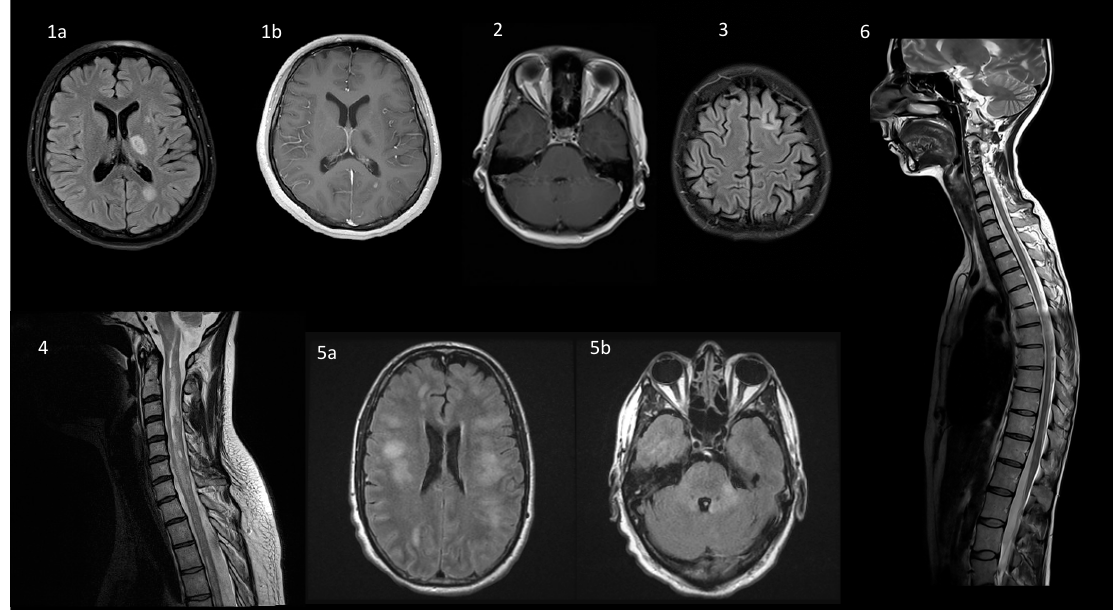
Figure 4. Typical magnetic resonance findings in a spectrum of diseases overlapping with MOGAD. ( 1 ) ADEM presentation in a 17-year old female with behavioral changes and transient right-sided paresis. On axial FLAIR ( 1a ), a periventricular lesion at the level of the left subcortical nuclei (17 × 11 mm) and the left ventricular triangle (15 × 10 mm) are visualized. On axial post-contrast T1-weighted image ( 1b ) slight contrast enhancement is present in the latter. ( 2 ) Optic neuritis in a 26-year old female with AQP4-ab positive NMOsd: bilateral enhancement of the optic nerves on axial T1-weighted post-contrast sequence. ( 3 ) Cortical involvement in a 22-year old female with MS: on axial FLAIR there is a 4 mm long linear hyperintensity that surrounds the cortical gyrus and involves both, the cortex and subcortical white matter. ( 4 ) AQP4-ab positive NMOsd in a 43-year old female: on a sagittal T2-weighted sequence LETM is visualized from C1–C2 to C5. ( 5 ) MOGAD in a 47-year old male presenting with ADEM with confirmed MOG-ab seropositivity. On axial FLAIR images there are diffuse nonspecific white matter hyperintensities involving both cerebral hemispheres, corpus callosum ( 5a ), posterior fossa ( 5b ), but periventricular lesions are lacking. ( 6 ) MOGAD in a 34-year old female presenting with spastic paraparesis, which improved significantly after a 5-day intravenous methylprednisolone course: on a sagittal T2-weighted sequence multiple hyperintensive poorly demarcated lesions are visible throughout the spinal cord, including the cervical and thoracic regions, and affecting medullary conus, as well. The lesions are not visible on T1-weighted sequence and are